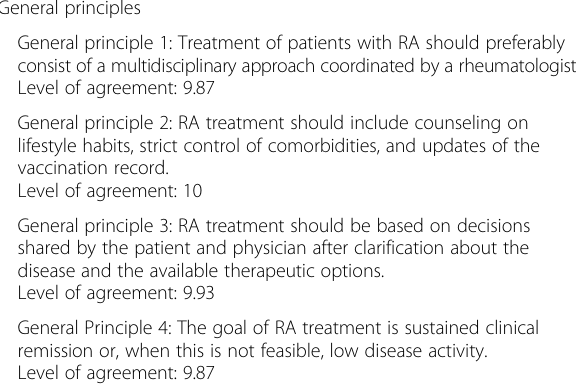
Table 3 General principles and recommendations of the Brazilian Society of Rheumatology for pharmacological treatment of rheumatoid arthritis in Brazil General